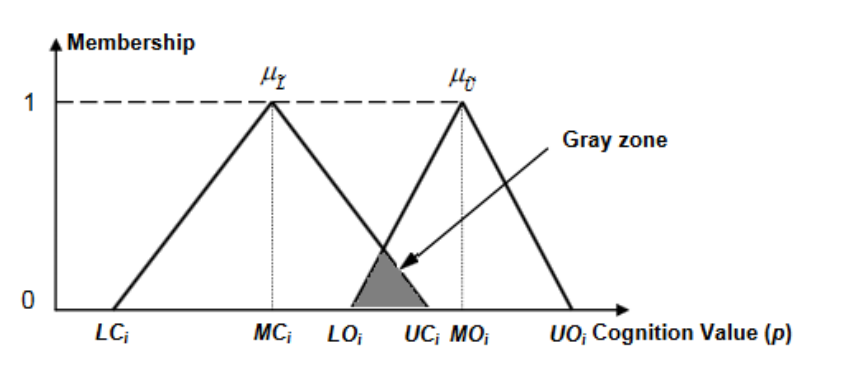
Fig. 3. Grey Area of C